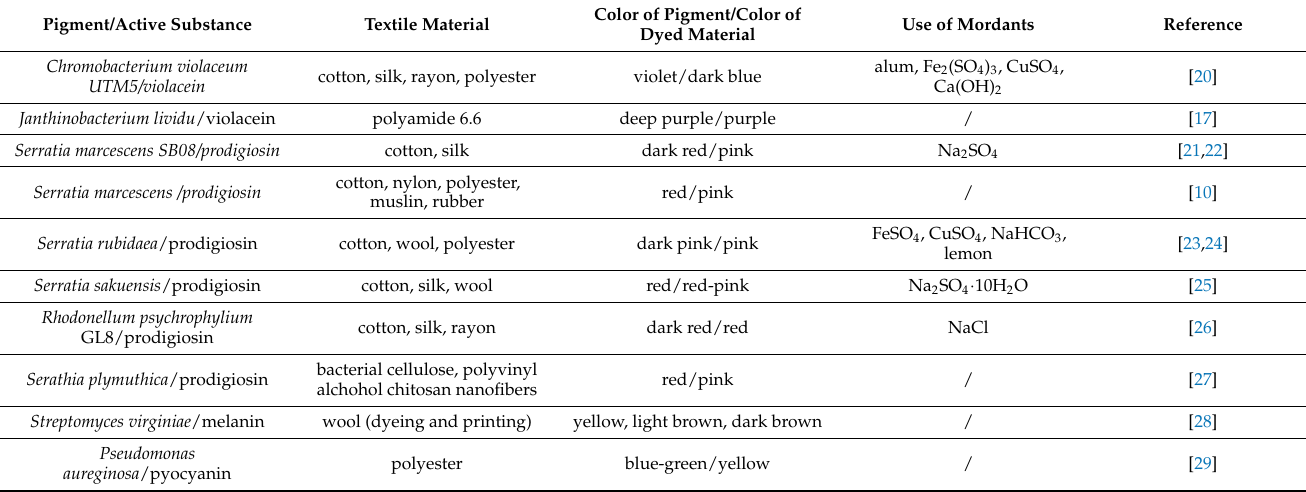
Table 1. Overview of different pigment-producing bacteria, use of pigments for different textile mate- rials, colors of the pigments and resulting colors of textiles, as well as auxiliaries in the dyeing process. Pigment/Active Substance Textile Material Color of Pigment/Color of Dyed Material Use of